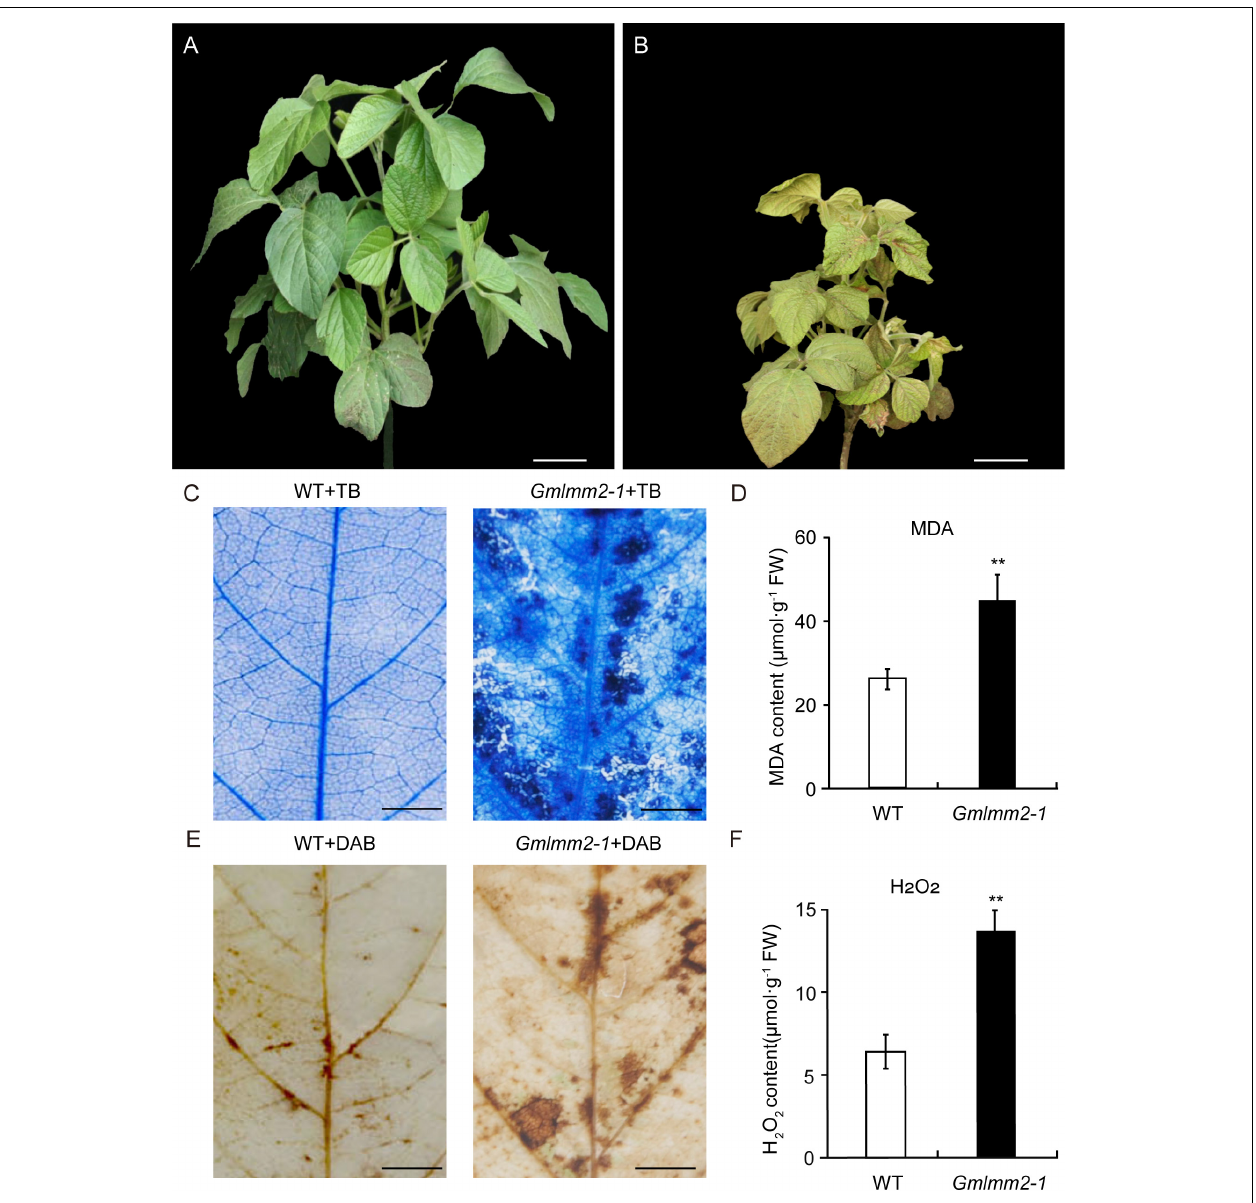
FIGURE 1 | “Williams 82” (A) and the Gmlmm2-1 mutant (B) plants. Scale bars = 10 cm. TB staining of leaves of “Williams 82” (C) and the Gmlmm2-1 mutant. Scale bars = 1 cm. (D) MDA contents in wild type and mutant leaves. DAB staining of leaves of “Williams 82” (E) and the Gmlmm2-1 mutant. Scale bars = 1 cm. (F) H 2 O 2 contents in wild type and mutant leaves. Asterisks indicate a significant difference by student’s t -test (** P < 0.01) and the error bars represent standard